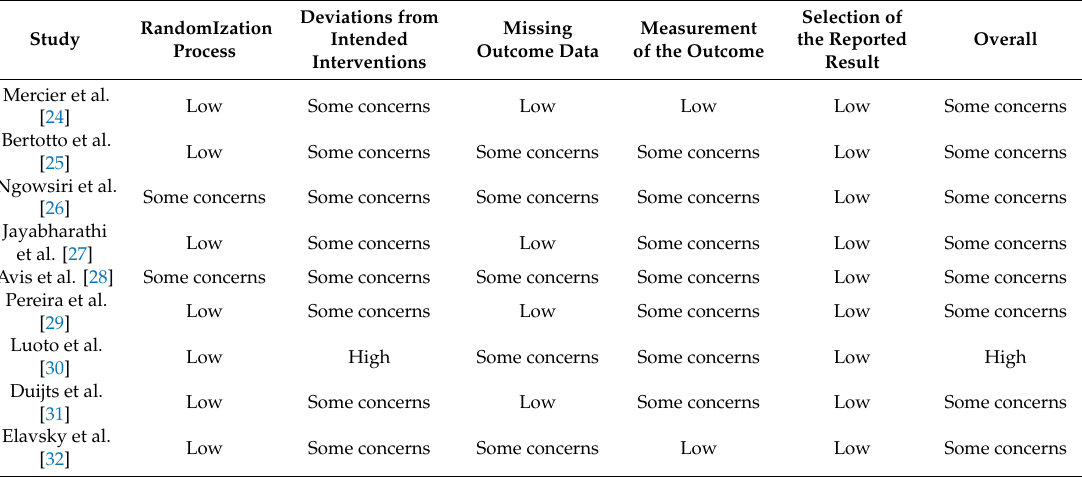
Table 4. Risk-of-bias assessment of the included